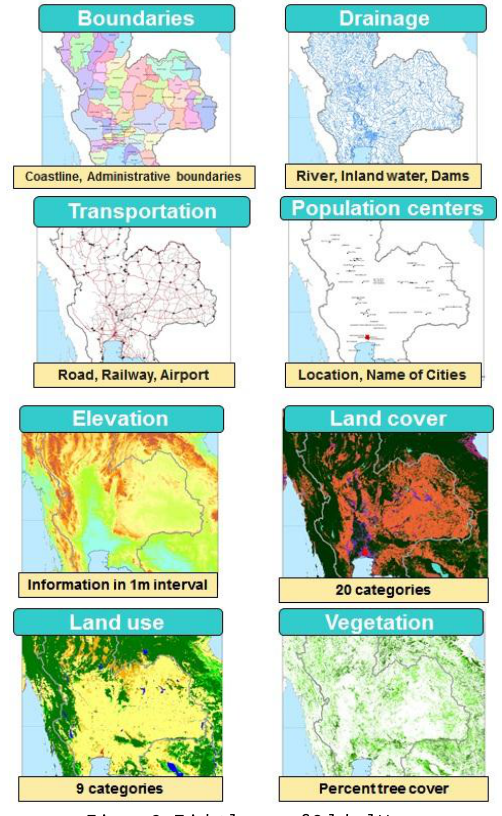
Figure 2: Eight layers of Global Map